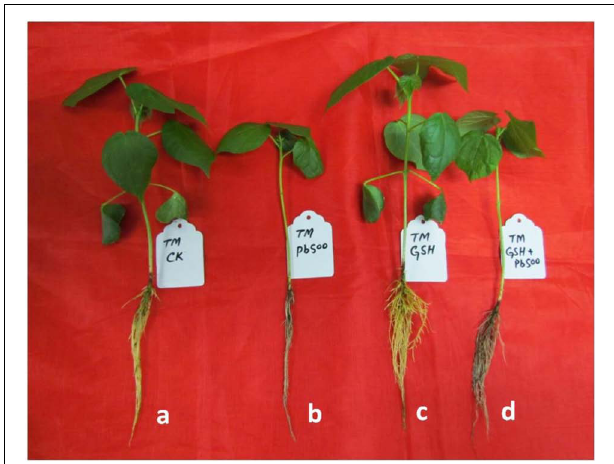
FIGURE 3 | Visual impact of Pb and GSH on upland cotton seedlings. Photographs of upland cotton seedlings (variety TM-1) representing control (a) , and those treated with 500 µ M Pb (b) , 50 µ M GSH (c) and 500 µ M Pb + 50 µ M GSH (d) .